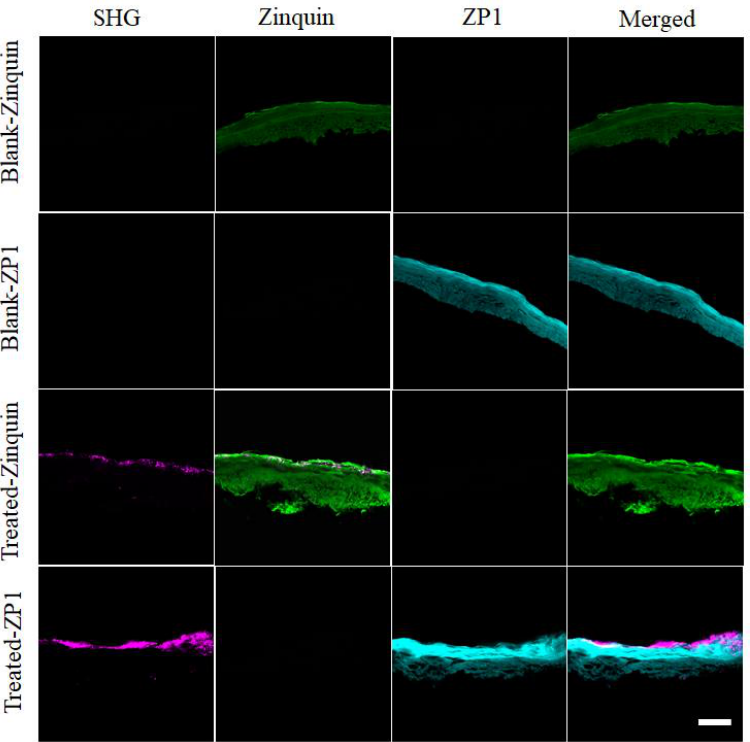
Figure 3. Multiphoton and confocal microscopy images of cross-sectioned HSEs post-treatment with either blank CCT formulation (Blank) or 67 ZnO-PEG (20% wt / wt ) in CCT formulation (Treated) for 48 h at 35 ± 1 °C. First and second rows show the images of blank HSEs stained with zinquin and ZP1, respectively. Third and fourth rows are the images of treated HSEs stained with zinquin and ZP1, respectively. From left, first, second, third and fourth columns show images of HSEs in SHG (magenta), zinquin (green), ZP1 (cyan) and merged channels, respectively. SHG signal of nano-sized 67 ZnO-PEG was acquired with multiphoton excitation/emission at 800 nm/400 nm. Zinquin signal was obtained with multiphoton excitation/emission at 740 nm/490 nm. For ZP1, excitation/emission was collected at 488 nm/540 – 560 nm using a 488-nm argon laser. Scale bar, 40 mm.